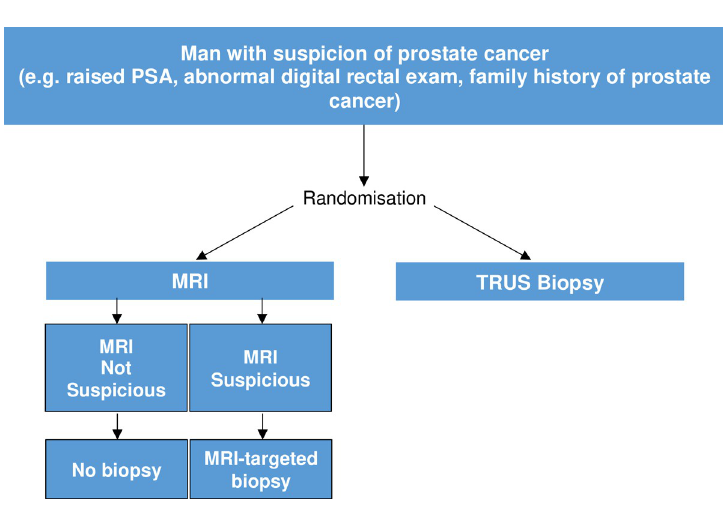
Fig 1. Study design of PRECISION, PRECISE and other potentially included studies in this